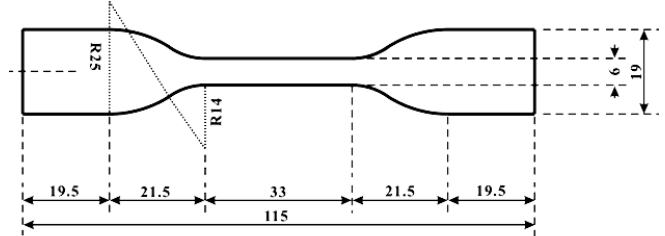
Figure 1. Dimensions of the sample (unit: mm). The thickness of the sample is 6 mm. Five different types of samples/hybrids—named SPPM x ( x = 1 to 5)—were produced. Refer to Table 1 for their actual compositions.